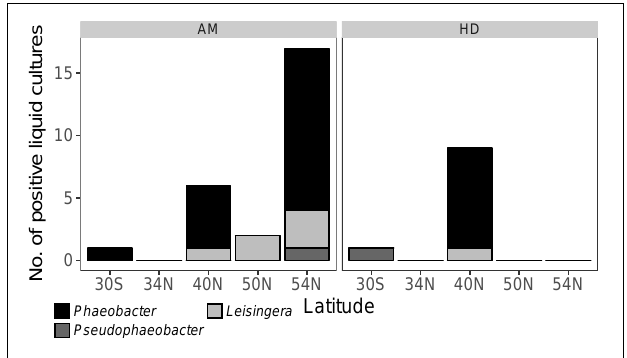
FIGURE 1 | Number of positive enrichments of Phaeobacter and phylogenetically related genera obtained from zooplankton > 300 µ m collected along a longitudinal transect in the Pacific (respective Latitudes of sampling sites are given) in defined medium AM or complex medium HD.